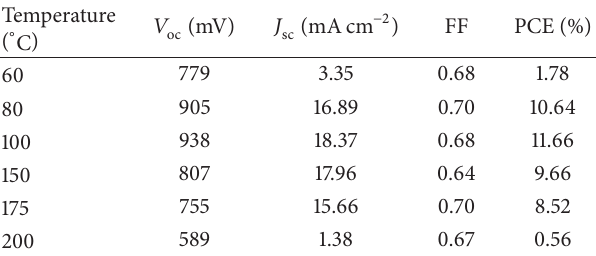
Table 1: Relevant photovoltaic performance data for devices annealed at various temperatures. Reproduced from [20] with permission from